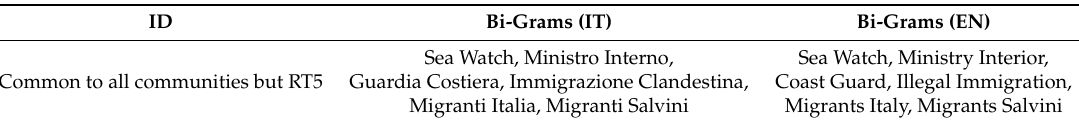
Table 5. Bi-grams in common to all communities, with the only exception being RT5, which did not share any bi-gram with the other communities.